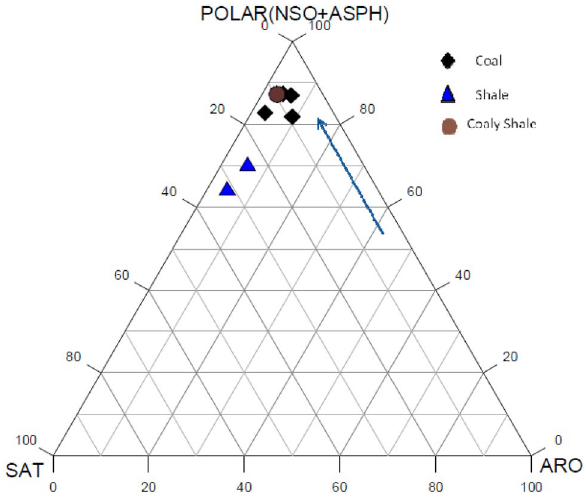
Fig. 20 Ternary diagram showing the proportion of satu- rated hydrocarbons, aromatic hydrocarbons and polar fraction (NSO + asphaltenes) in extracts of coal, shale and coaly shale source rocks of Maiganga, Gombe Formation. The samples have higher per- centage of heterocompounds indicated by the arrow. After Clayton and Law (1993)